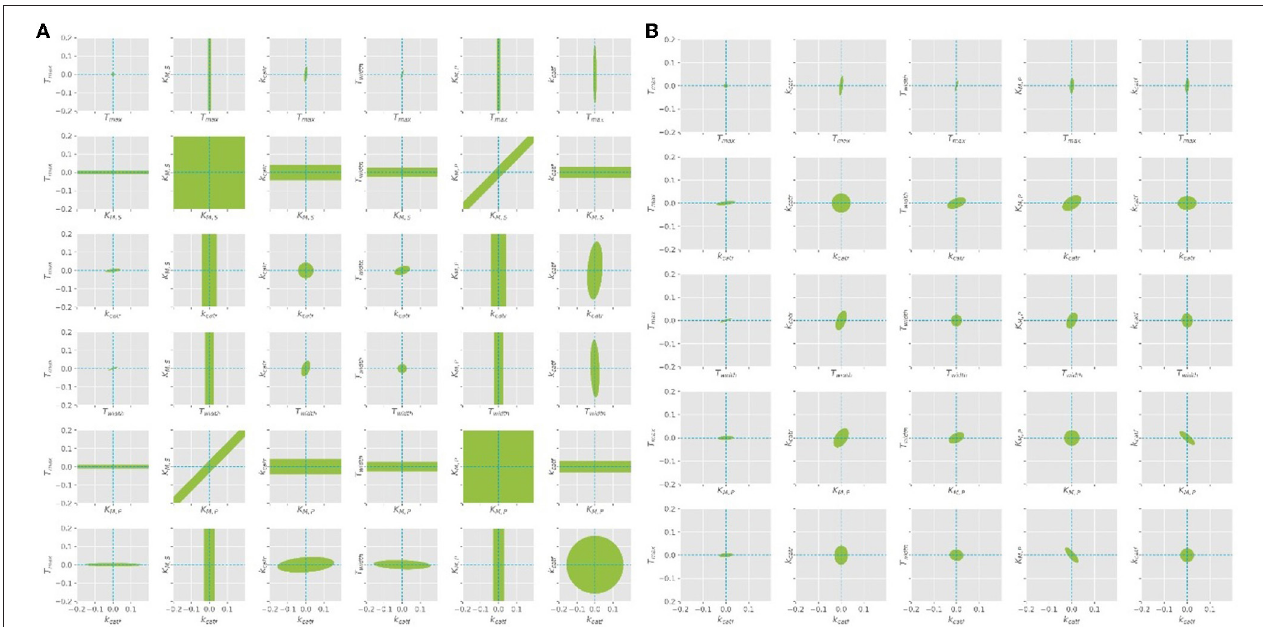
FIGURE 5 | Confidence ellipses for the optimal parameters obtained with the quasi steady state assumption. (A) Leaving K M , S free, (B) K M , S is fixed at constant value of 1.3 as derived from literature.